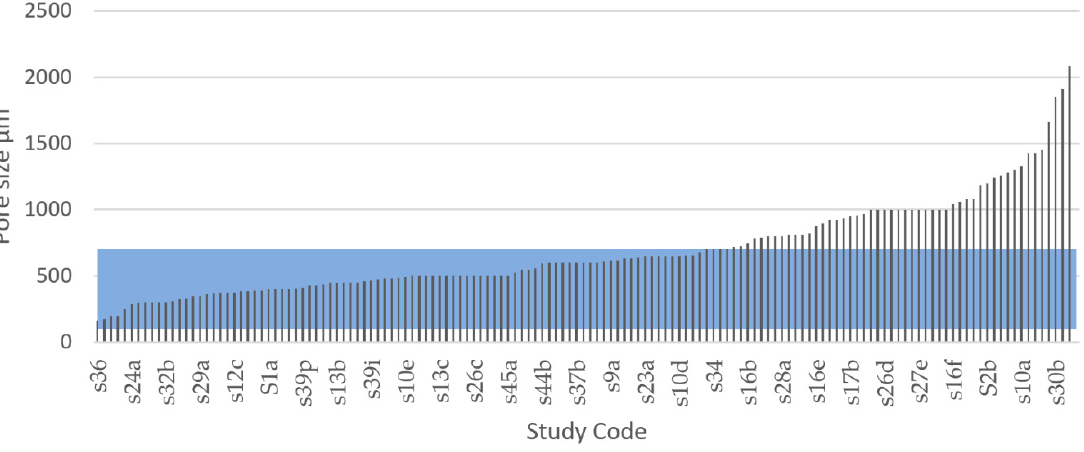
Figure 10. The pore sizes recorded in the reviewed articles, compared with the Ideal Quality Attribute IQA target zone.